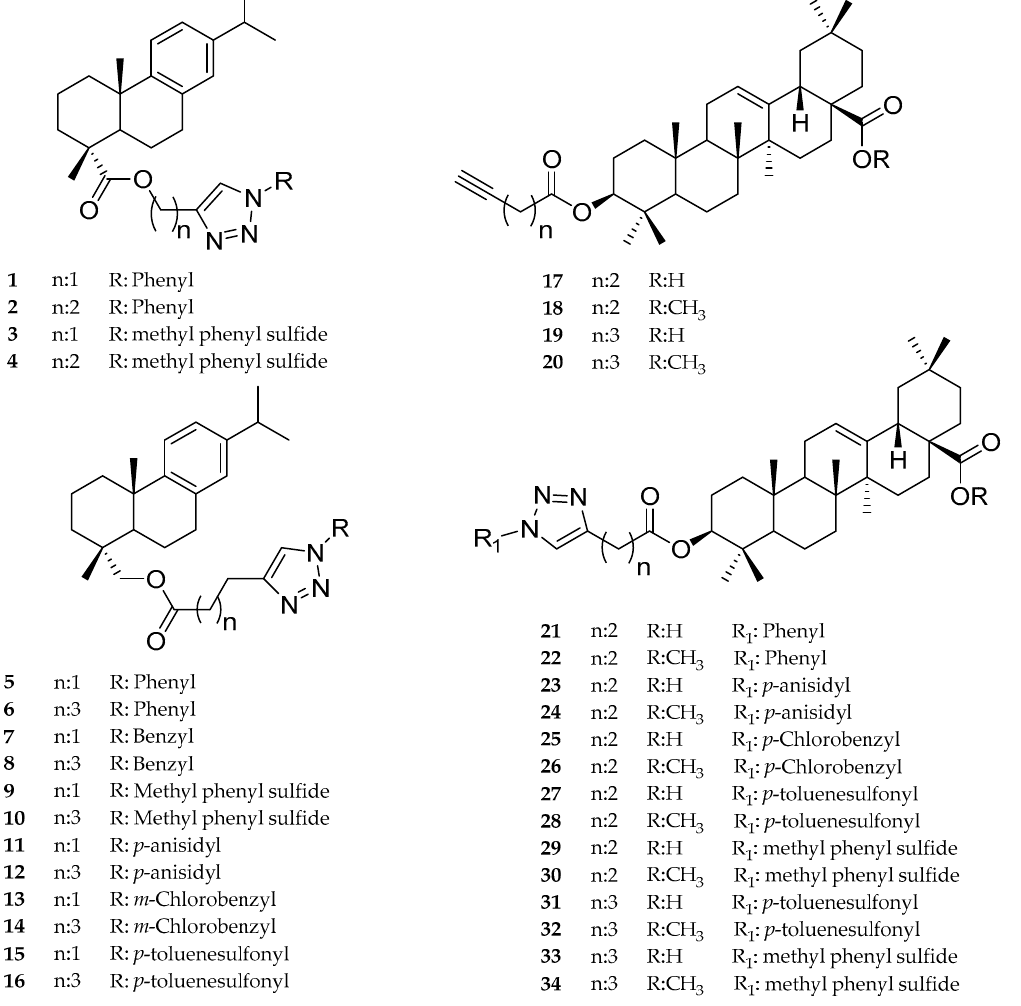
Figure 1. The structure of compounds 1 – 34 synthesized and evaluated as antiprotozoal agents in vitro.